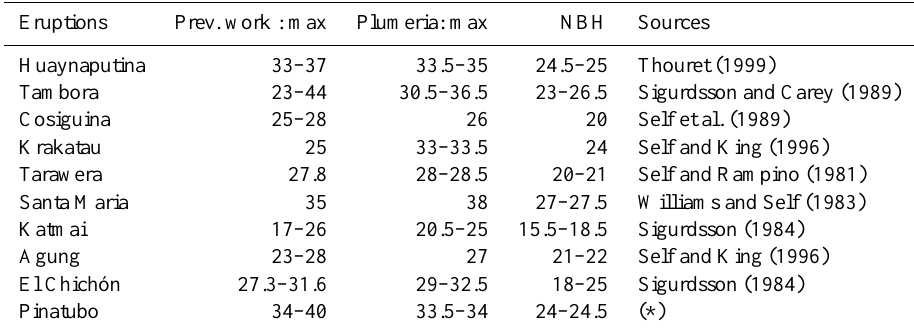
Table 2. Altitude (km) of maximum injections for previous studies and Plumeria simulations, as well as the neutral buoyancy heights (NBH) in Plumeria. Eruptions Prev. work : max Plumeria: max NBH